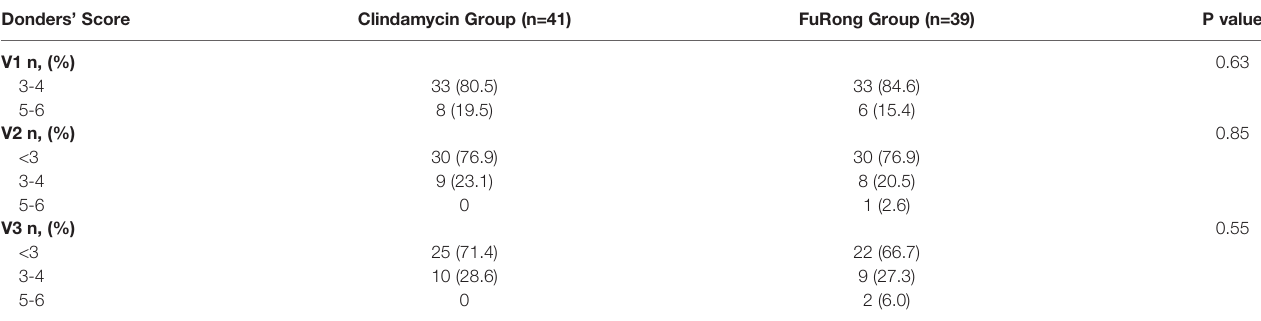
TABLE 4 | Donders ’ score during the three follow-up periods.